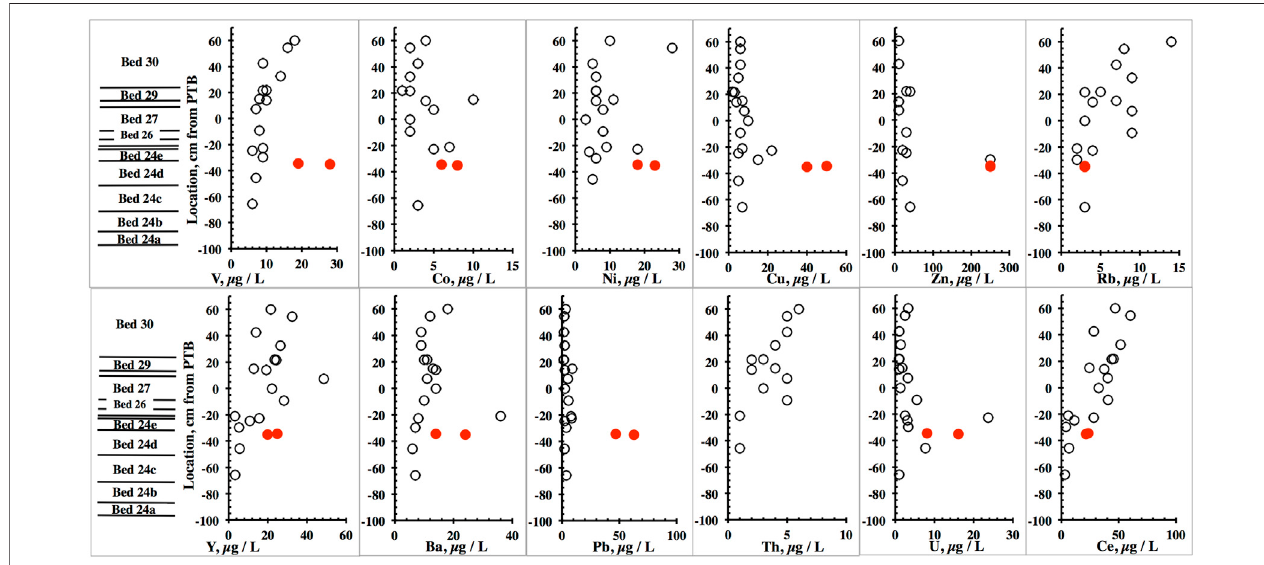
FIGURE 6 | Trace element data for acetic acid extracts, plotted stratigraphically. Data for bed 24d are shown in red.